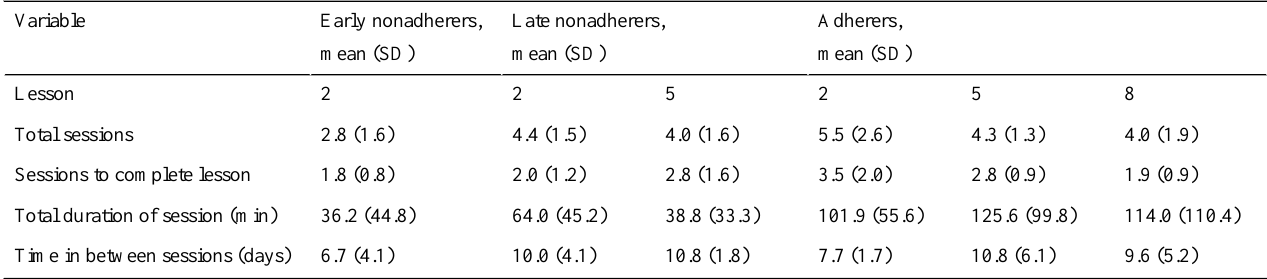
Table 4. Mean number of sessions and duration for early nonadherers (n=5), late nonadherers (n=5), and adherers